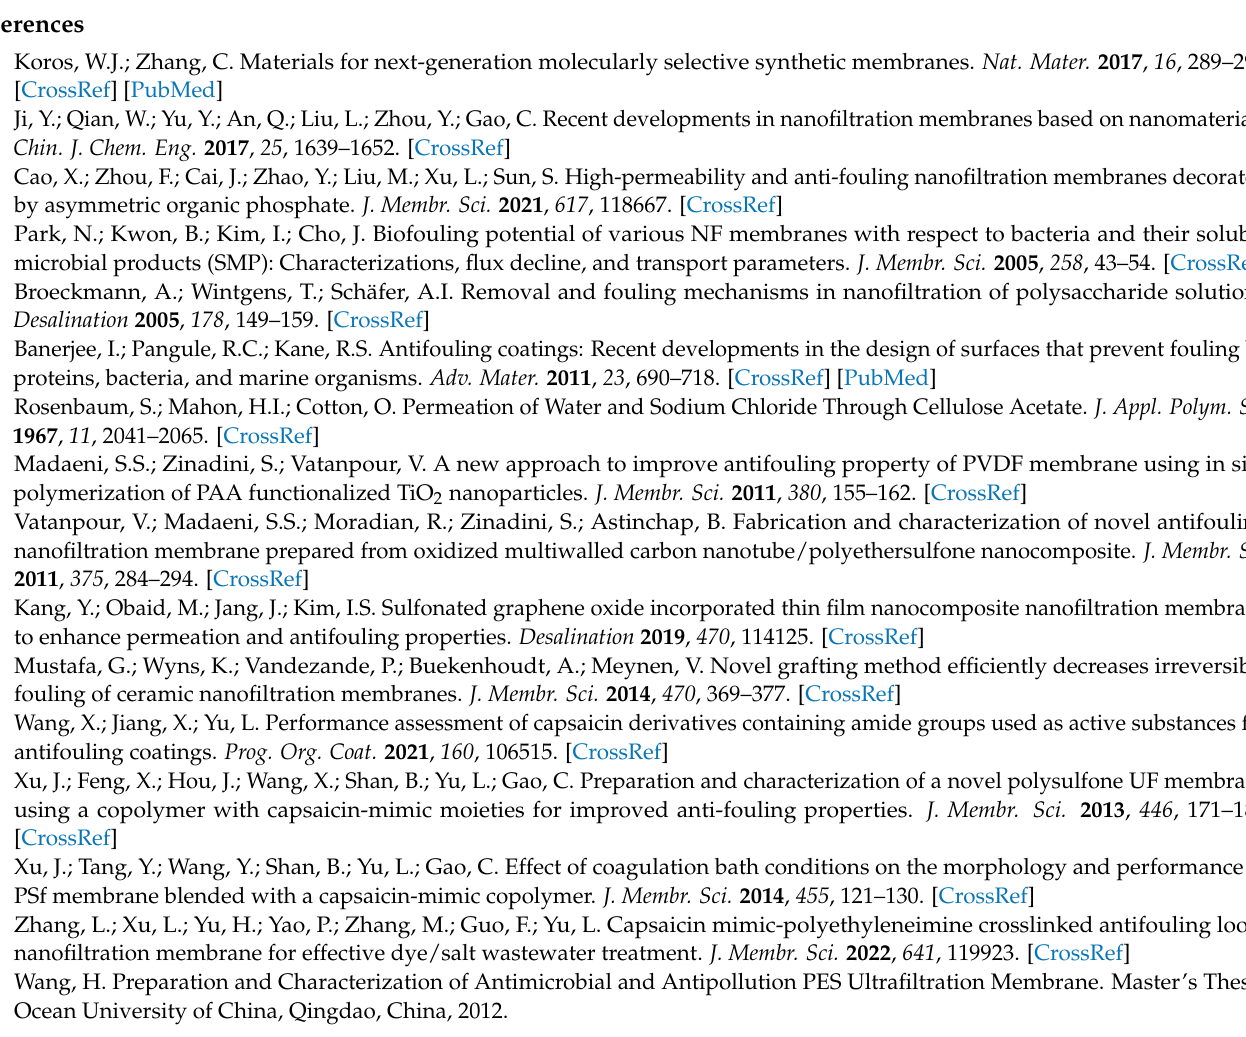
Figure S2: Theoretical molecular formulas of interfacial polymerization among PIP, PAMTB, and TMC; Figure S3: The cross-section structure of the PA-PHMTBA 0.05 membrane; Figure S4: Photos of the PIP/PHMTBA aqueous phase solution; Figure S5: Local SEM surface images of unmodified and PHMTBA-modified TFC membranes; Table S1: The hydrated radius of different ions. Reference [50] is cited in supplementary